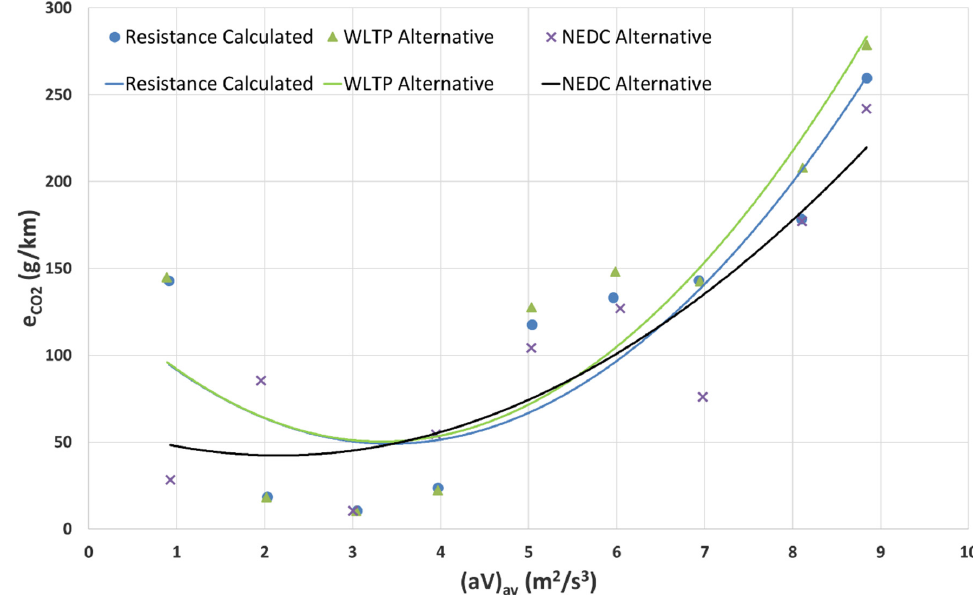
Figure 8. Comparison of the relationship between the CO 2 emission rate and the average product of speed and acceleration for the analysed dynamometer load settings. speed and acceleration for the analysed dynamometer load